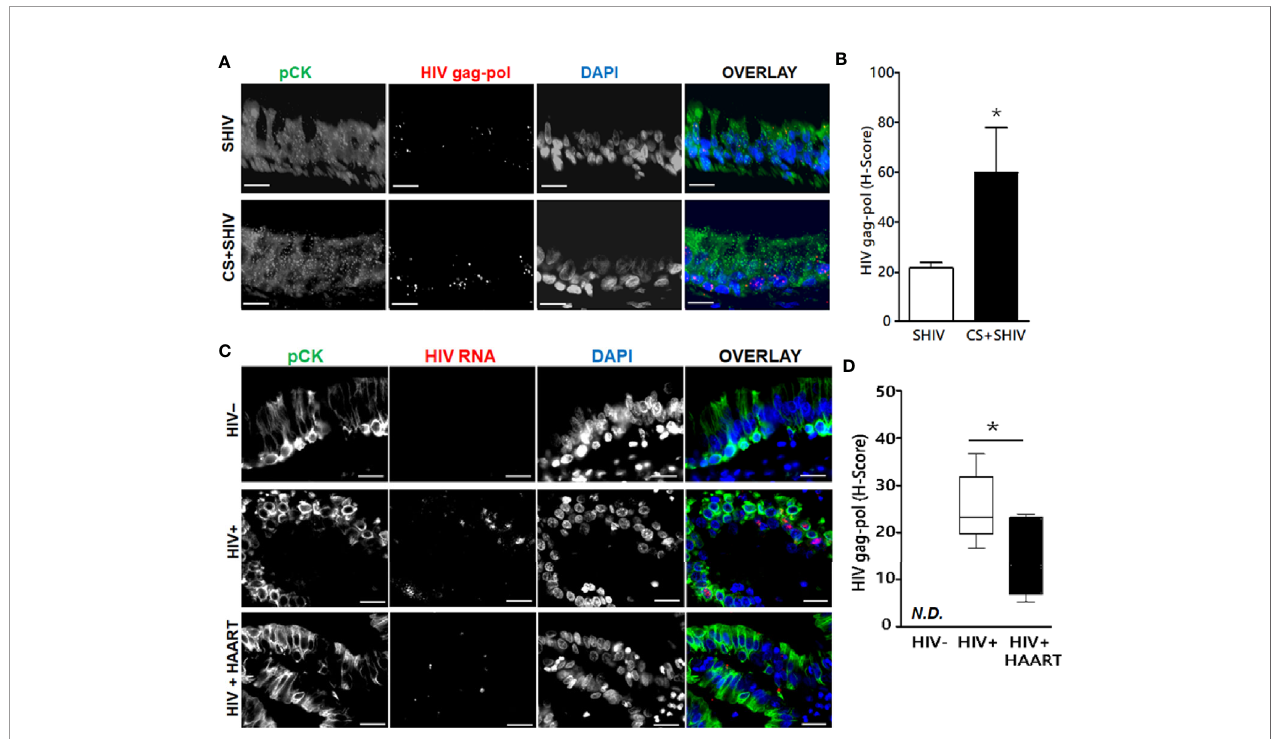
FIGURE 4 | Expression of HIV-gag-pol RNAs in the lung epithelial cells of SHIV-infected macaques and HIV-infected human subjects treated with antiretrovirals. Archived 5 m m FFPE lung tissue sections were used for HIV-1-gag-pol RNA detection using RNAscope ® and immunostained for the epithelial cell marker, pan- cytokeratin (pCK). (A) Representative micrographs of bronchial epithelial cells showing pan-cytokeratin, pCK (green), and HIV-gag-pol (red) colocalization along with the DAPI-stained nuclei (blue) from SHIV- and CS+SHIV-infected groups; CS, cigarette smoke, Scale — 5µ. (B) Quanti fi cation of epithelial HIV-gag-pol expression denoted as H-score, see Materials and Methods for details; *p < 0.05. (C) Representative micrographs of bronchial epithelial cells showing pCK (green) and HIV- gag-pol (red) colocalization along with the DAPI-stained nuclei (blue) in archived lung tissues from HIV-negative controls (HIV − ), and from HIV-infected (HIV+) subjects and HIV+ subjects on HAART treatment (HIV+HAART). Scale — 5µ. (D) Quanti fi cation of HIV-gag-pol expression in bronchial epithelial cells (denoted as H-score). N.D., Not detected. Data are shown as mean ± SEM; n = 4/group; *p <